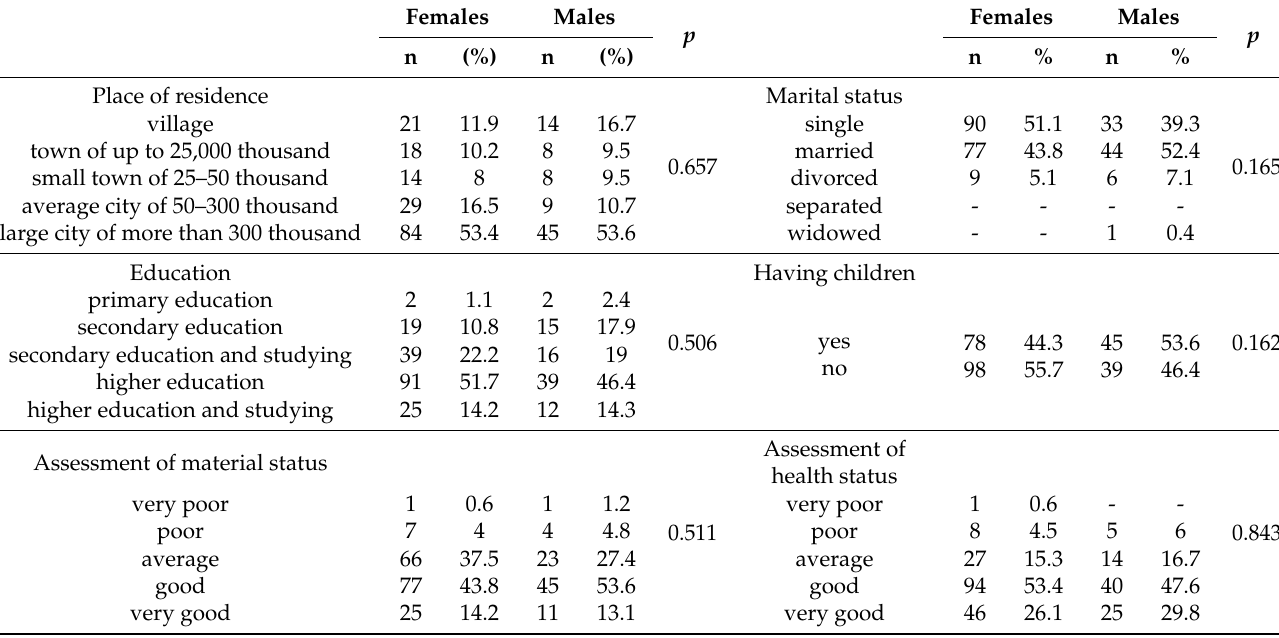
Table 1. Sociodemographic data differences between females and males by Pearson’s Chi-square test.